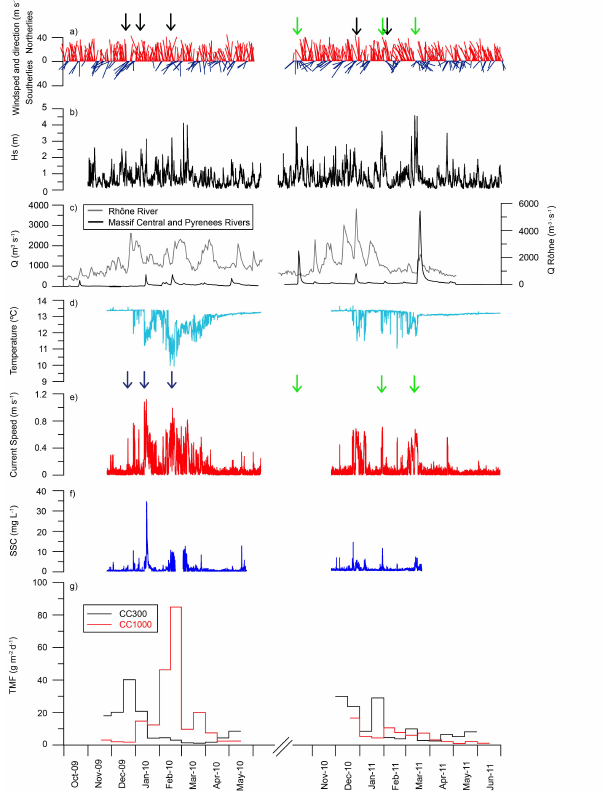
Fig. 2. (a) Temporal variability of northerly winds (red) and southerly winds (blue). Black arrows highlight severe N-NW wind episodes and green arrows the occurrence of eastern storms (b) Sig- nificant wave height (Hs); (c) Daily fluvial discharges of the Rhˆone River in grey and the sum of the main small rivers flowing to the Gulf of Lions (H´erault, Orb, Agly, Aude, Tech and Tˆet) in black; (d) near-bottom temperature recorded at CC300; (e) near-bottom current speed recorded at CC300, (f) suspended sediment concen- tration (SSC) as recorded by the currentmeter at 300m of water depth; (g) total mass flux at 300 (black) and 1000m (red) of water depth. Blue arrows show period of intense heat losses and DSWC event (as in Figs. 3 and 5), and green arrows the occurrence of east- ern storms (as in Fig.